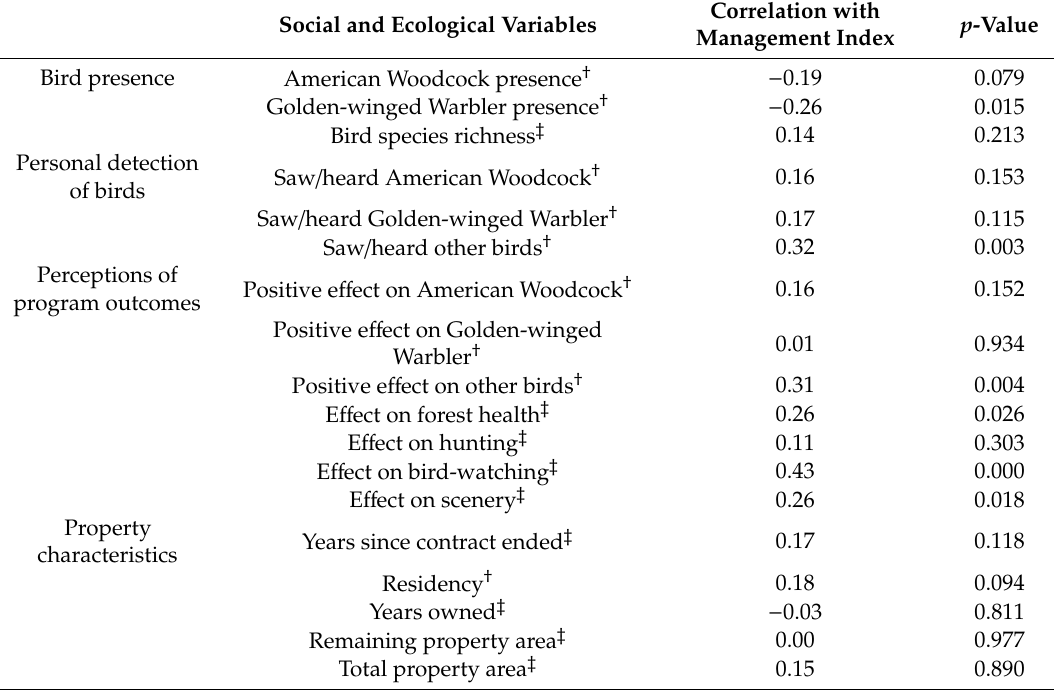
Table 3. Bivariate correlations between bird presence, landowner bird detections, landowner perceptions, property and early successional forest management after NRCS program participation, eastern United States, February–May 2017 (n = 85). Correlation with p -Value Social and Ecological Variables Management Index American Woodcock presence